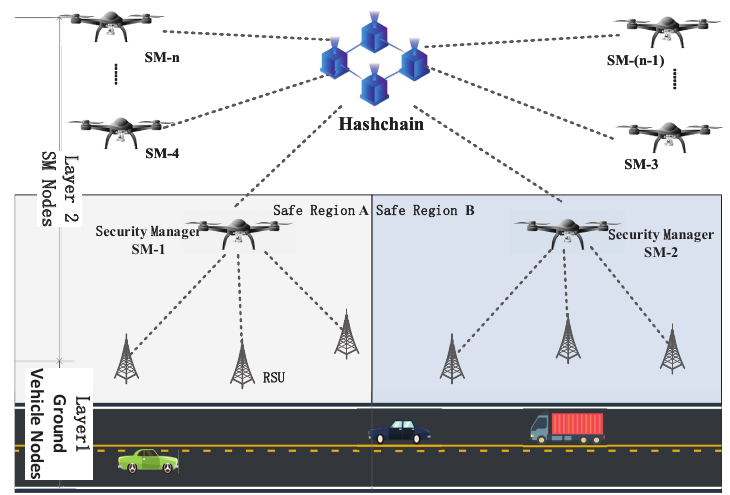
Figure 3. Cross-regional identity information management structure based on the hash chain.